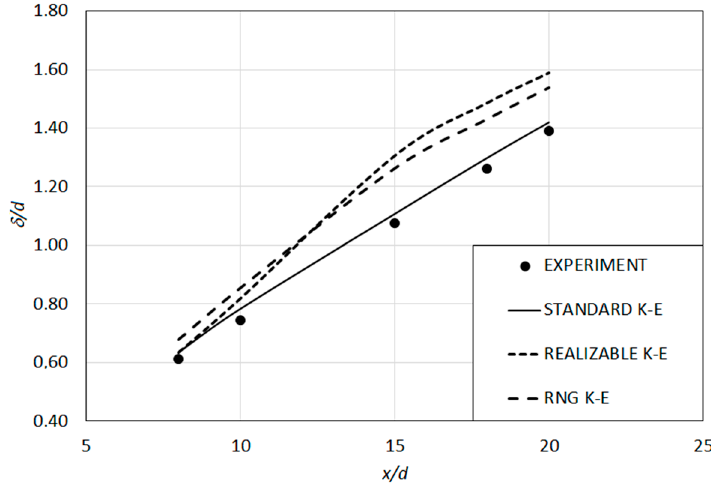
Figure 5. Variation of predicted half value radius along jet axis (isothermal test case).